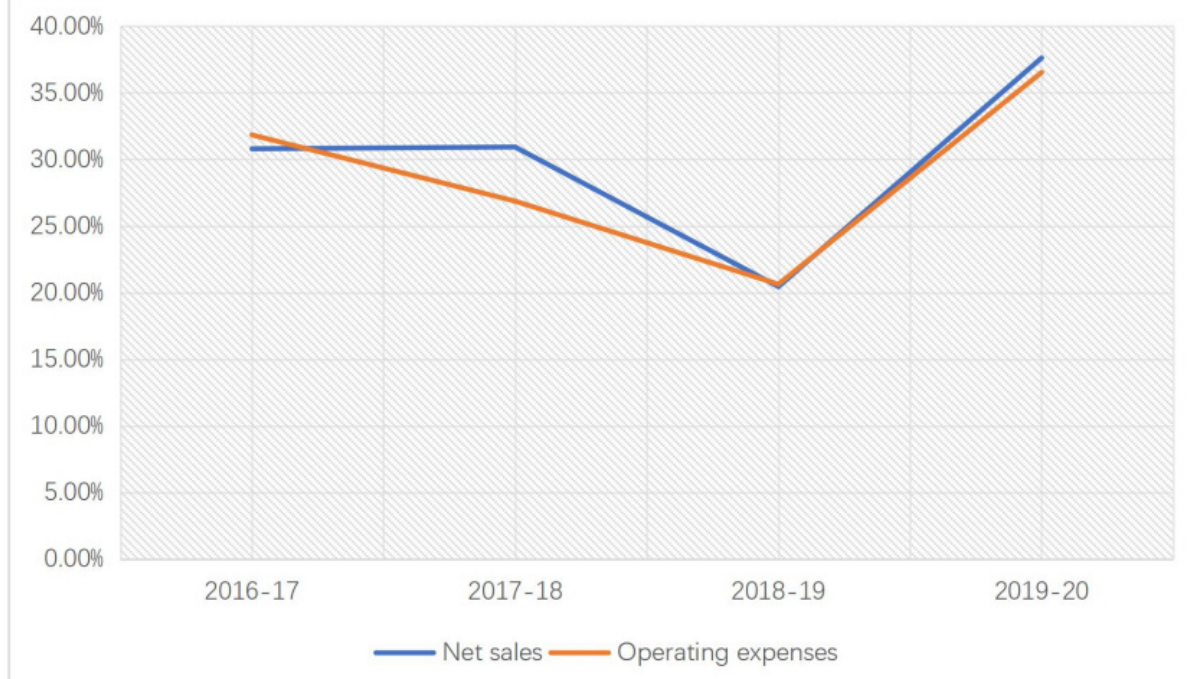
Figure 5. Amazon’s net sales % operating sales change trend line.